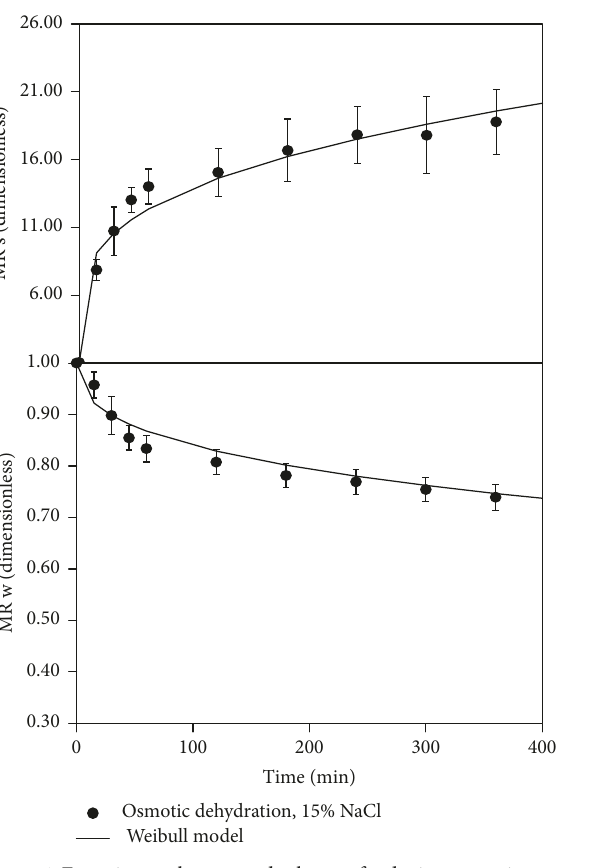
Figure 1: Experimental water and salt transfer during osmotic proc- ess and calculated by Weibull model.